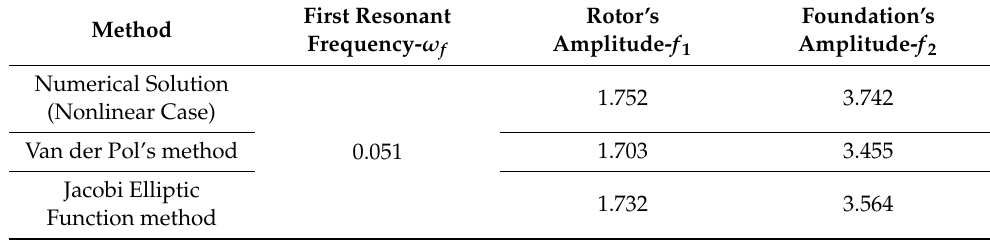
Table 1. Amplitude values at the first resonance for different methods.